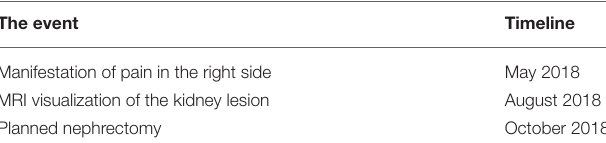
TABLE 1 | A table summarizing care checklist organized into a timeline. Some areas of the multichamber lesion did not have muscle